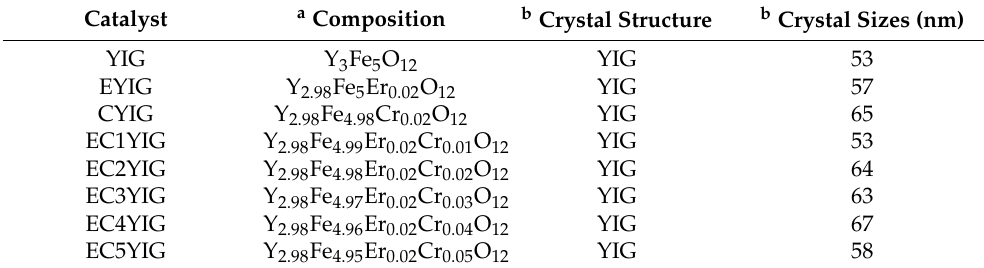
Table 1. Physicochemical characterizations of the fresh yttrium iron garnet ferrite catalysts studied.